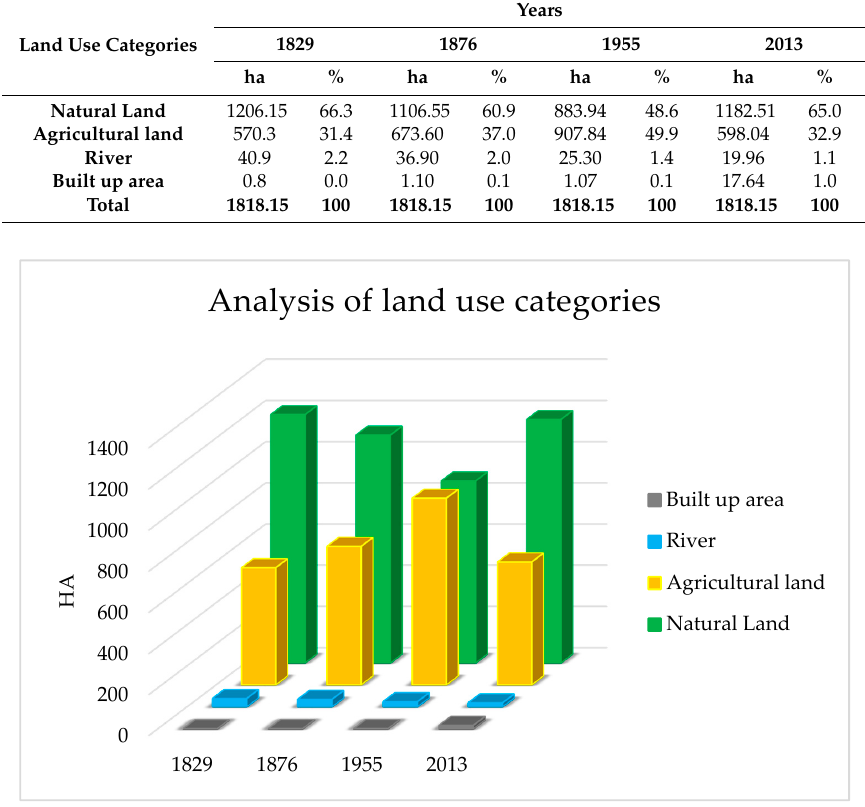
Figure 5. Analysis of land use categories in different periods.